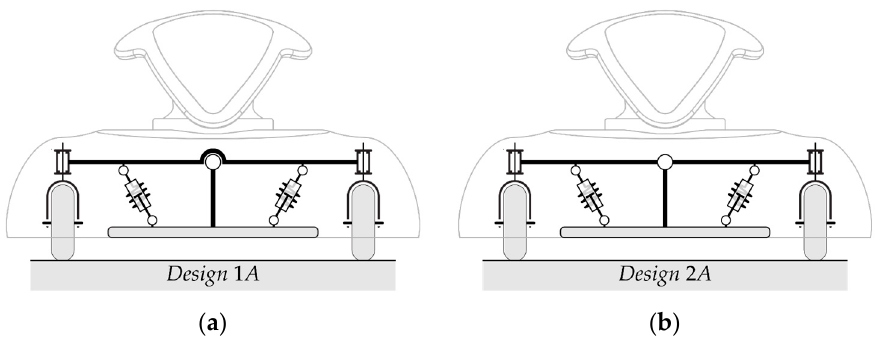
Figure 5. Suspensions configurations: ( a ) one-arm configuration (named 1A); ( b ) two-arms configurations (named 2A).